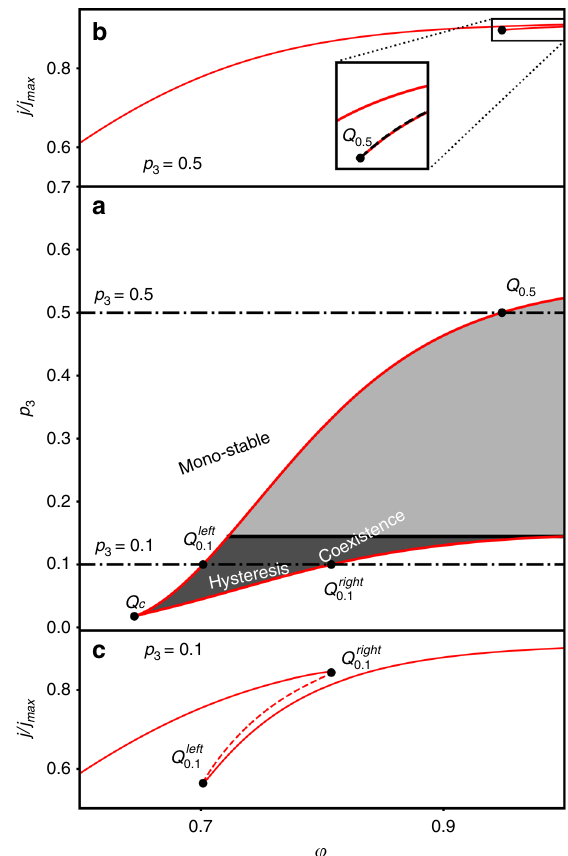
Fig. 5 Bi-stability and hysteresis. a Coexistence parameter space for the computed normalized photocurrent voltammograms showing the distinct regions of coexisting solutions. 2D projection of the manifold describing the computed normalized photocurrent voltammograms ( j / j max ) as a function of the applied dimensionless potential ( φ ) and H 2 O 2 concentration ( p 3 ), showing the coexistence (bi-stability) regime of the normalized photocurrent (the grey shaded area). The bold dashed line indicates the threshold between observable and non-observable hysteresis. b , c Simulated normalized photocurrent voltammograms at p 3 = 0.5 and 0.1, respectively. Solid lines indicate stable solutions, whereas dashed lines indicate unstable ones. The transition points from stable to unstable solutions and vice versa in b , c are, respectively, marked in